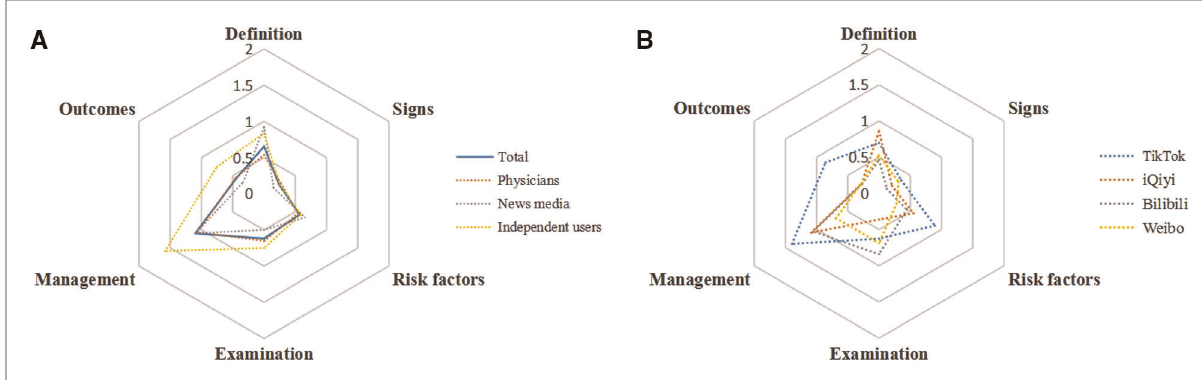
FIGURE 3 Hexagonal Radar Charts of videos. ( A ) Videos from different sources. ( B ) Videos on different platforms.